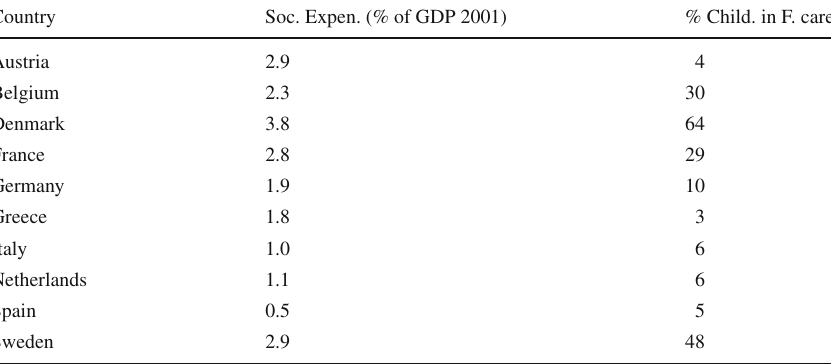
Table 1 Public social expenditure in family policies and proportion of children (aged under 3) in formal care. Source : OECD (2004) Social Expenditure Database and OECD (2001) Country Soc. Expen. (% of GDP 2001) % Child. in F. care